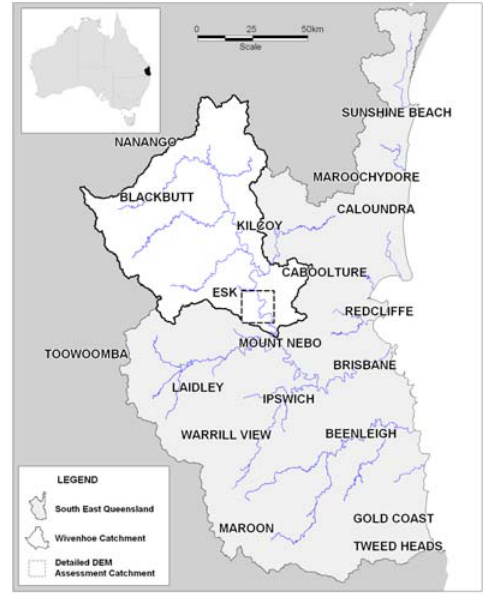
Figure 2. Examples of Raw Data